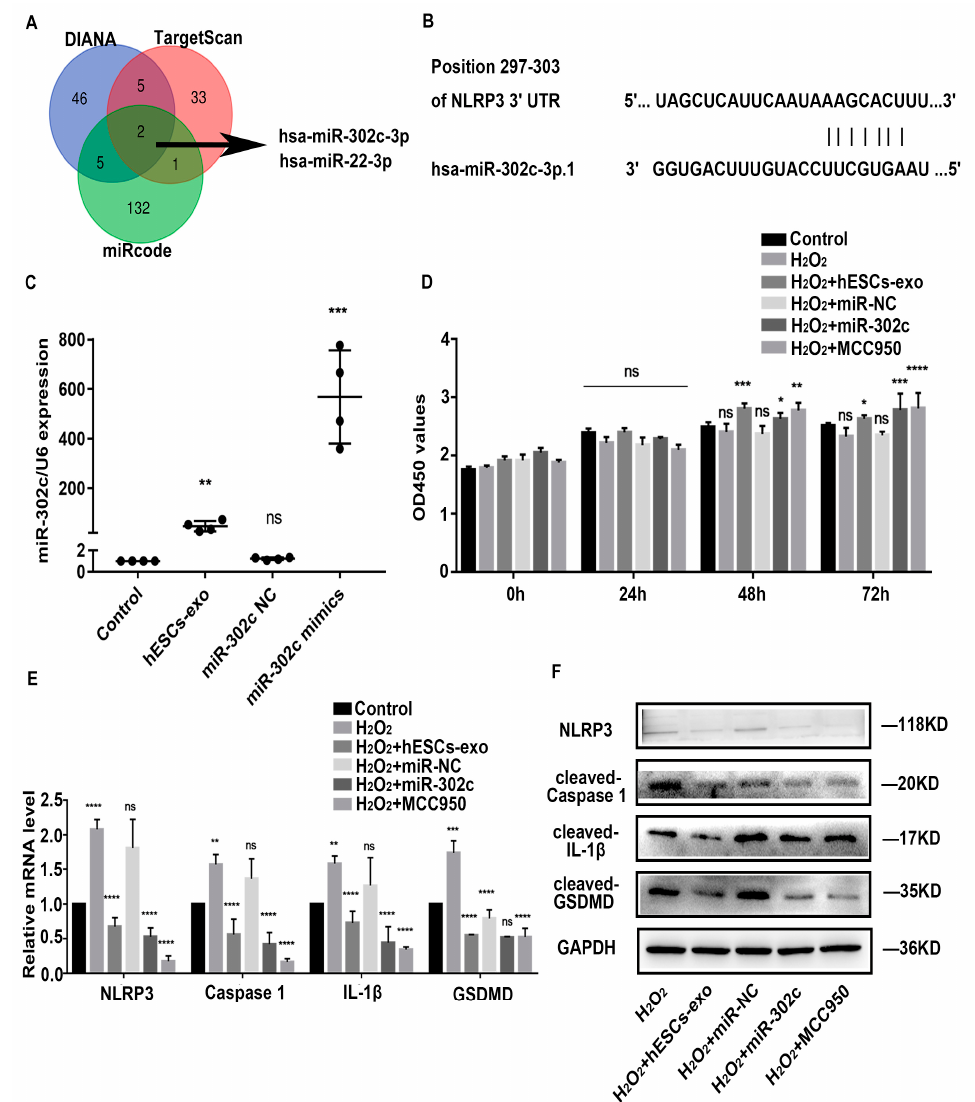
Figure 3. hESCs-exo-derived miR-302c targets NLRP3 to alleviate pyroptosis of NPCs. ( A ). Venn graph showing the prediction results of NLRP3 targets in DIANA, miRcode, and TargetScan software packages. ( B ). Sequence alignment of one putative miR-302c-binding site within the 3 (cid:48) UTR of NLRP3 mRNA shows a high level of sequence conservation and complementarity with miR-302c. ( C ). qRT-PCR was used to evaluate the expression of miR-302c in NPCs treated with corresponding treatments, n = 4. The data are shown as the means ± SD. ns, non-significant; the hESCs-exo group compared to the control group, the miR-302c negative controls (NC) group compared to the control group, the miR-302c mimic group compared to the miR-302c NC group. ( D ). CCK8 assay was used to evaluate the cell viability in NPCs treated with corresponding treatments, n = 5. ( E ). qRT-PCR was used to evaluate the expressions of NLRP3 , caspase 1 , IL-1 β , and GSDMD in NPCs after corresponding treatments, n = 3. ( F ). WB analysis of NLRP3, cleaved-caspase 1, cleaved-IL-1 β , and cleaved-GSDMD in NPCs after corresponding treatments, n = 3. The data are shown as the means ± SD. The H 2 O 2 group compared to the control group, the H 2 O 2 + hESCs-exo group compared to the H 2 O 2 group, the H 2 O 2 + miR-302c NC group compared to the H 2 O 2 group, the H 2 O 2 + miR-302c mimic group compared to the H 2 O 2 + miR-302c NC group, the H 2 O 2 + MCC950 group compared to the H 2 O 2 group; ns, non-significant, * p < 0.05, ** p < 0.01, *** p < 0.001, **** p <